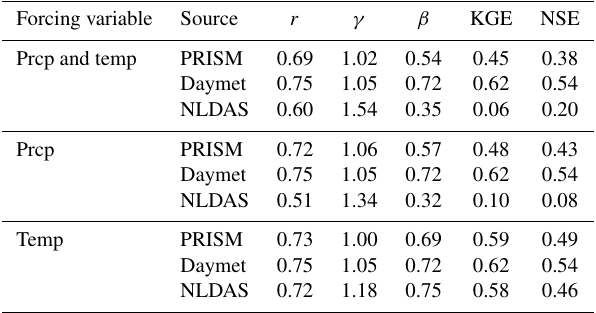
Table 2. Summary of statistical metrics for evaluation of streamflow at the watershed outlet using precipitation and/or temperature from different meteorological